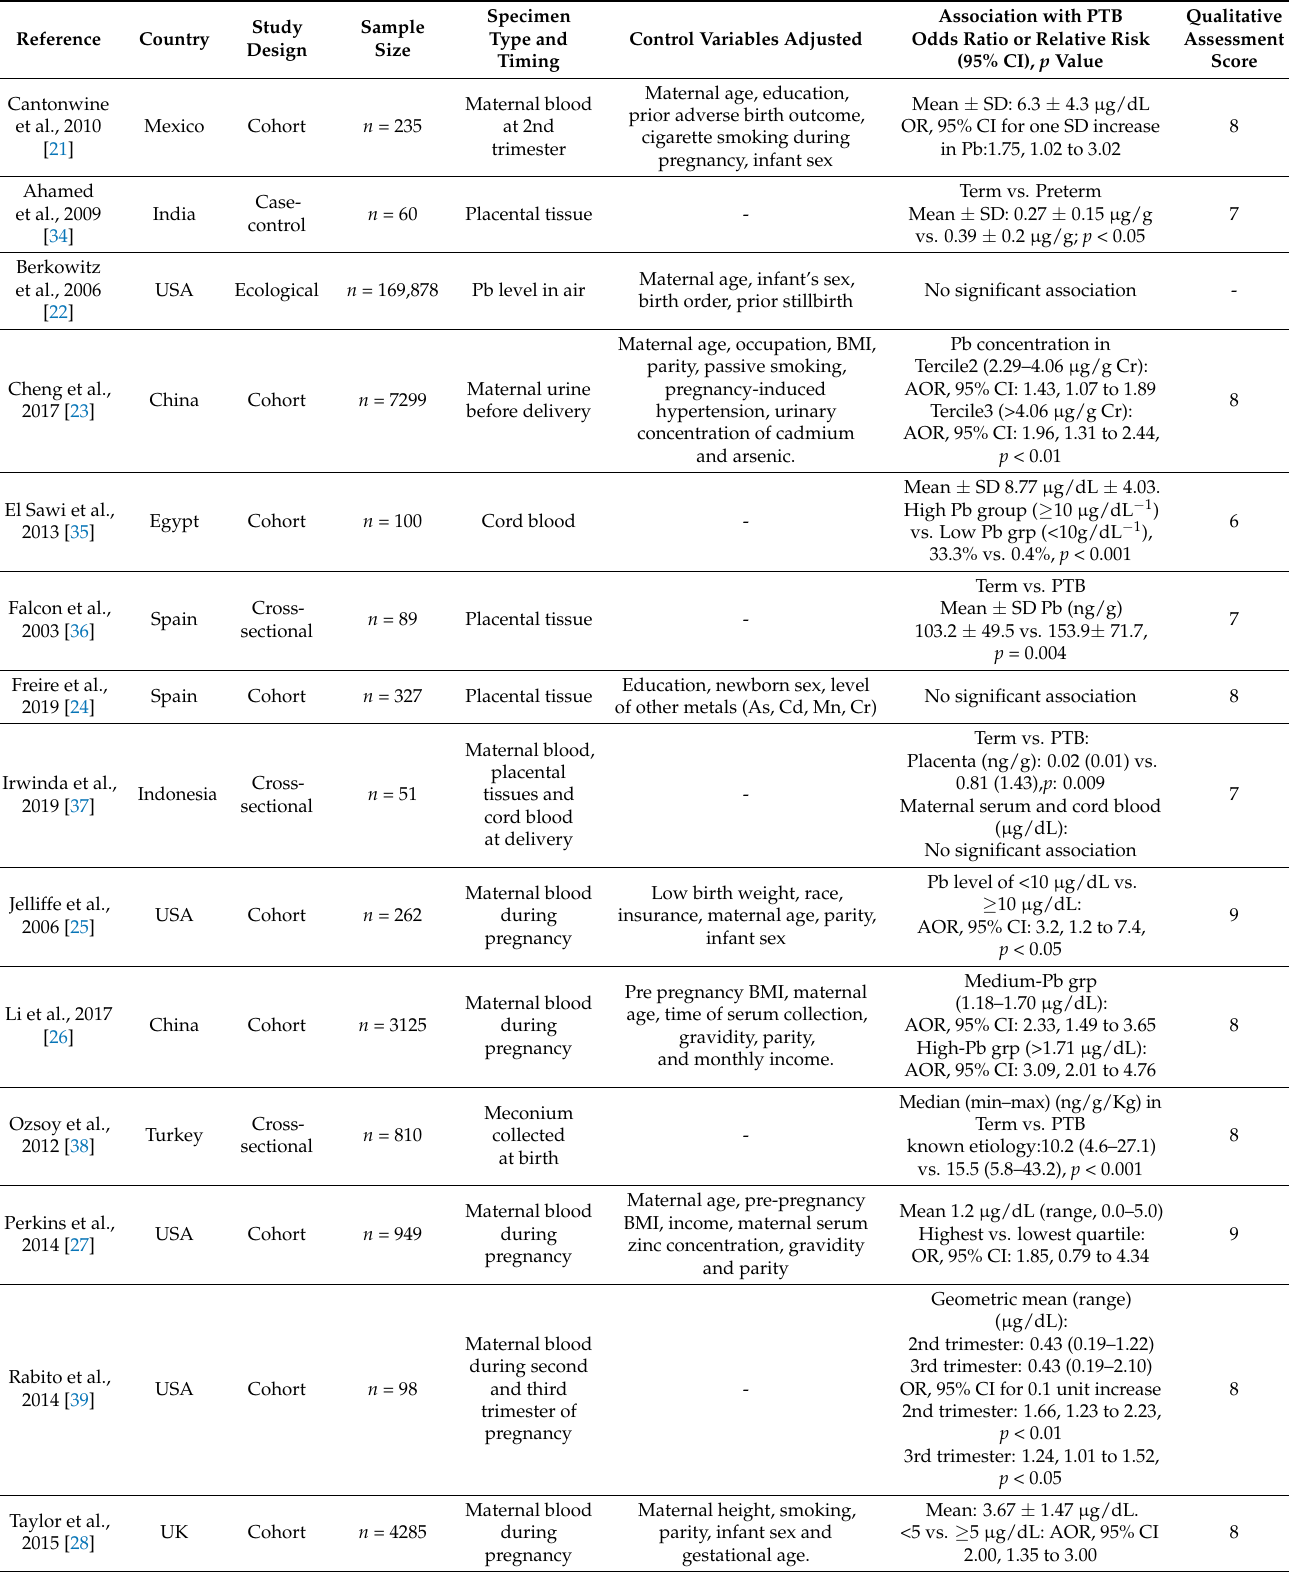
Table 1. Association between Lead and